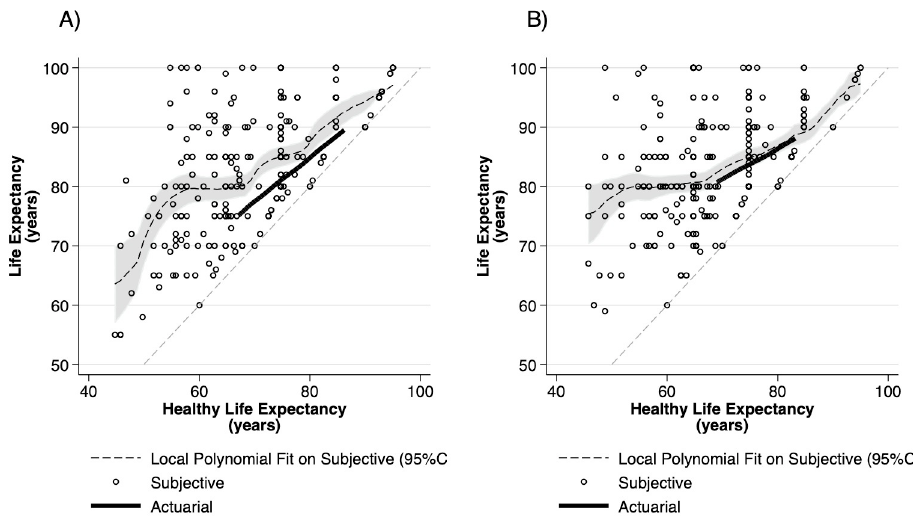
Fig 4. Healthy life expectancy vs life expectancy in A) wen and B)